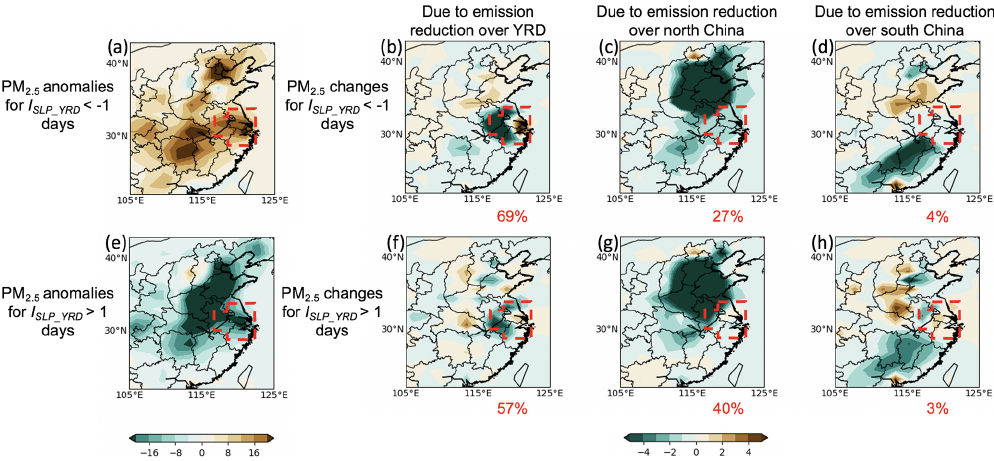
Figure 9. PM 2 . 5 anomalies with respect to the winter mean (µgm − 3 ) for (a) days with I SLP_YRD < − 1 and (e) days with I SLP_YRD > 1 during DJF 2014–2018, and PM 2 . 5 changes (µgm − 3 ) for the same days due to emission reductions over (b, f) YRD, (c, g) northern China, and (d, h) southern China. The red box represents the YRD region. The relative shares of the total PM 2 . 5 reduction over YRD from local, north, and south are labelled in the bottom right of panels (b) – (d) and (f) – (h) .